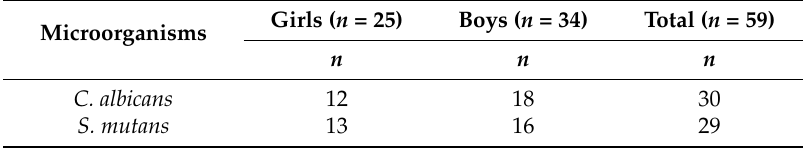
Table 2. Frequency of isolation of S. mutans and yeasts in the studied groups of